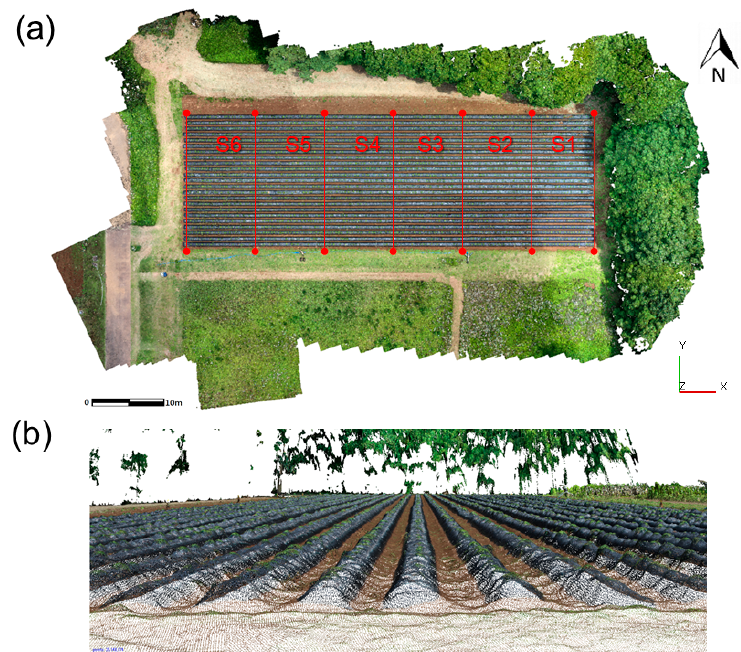
Figure 2. The dense point cloud model based on 33 days after planting (DAP). ( a ) Top view; ( b ) side view.